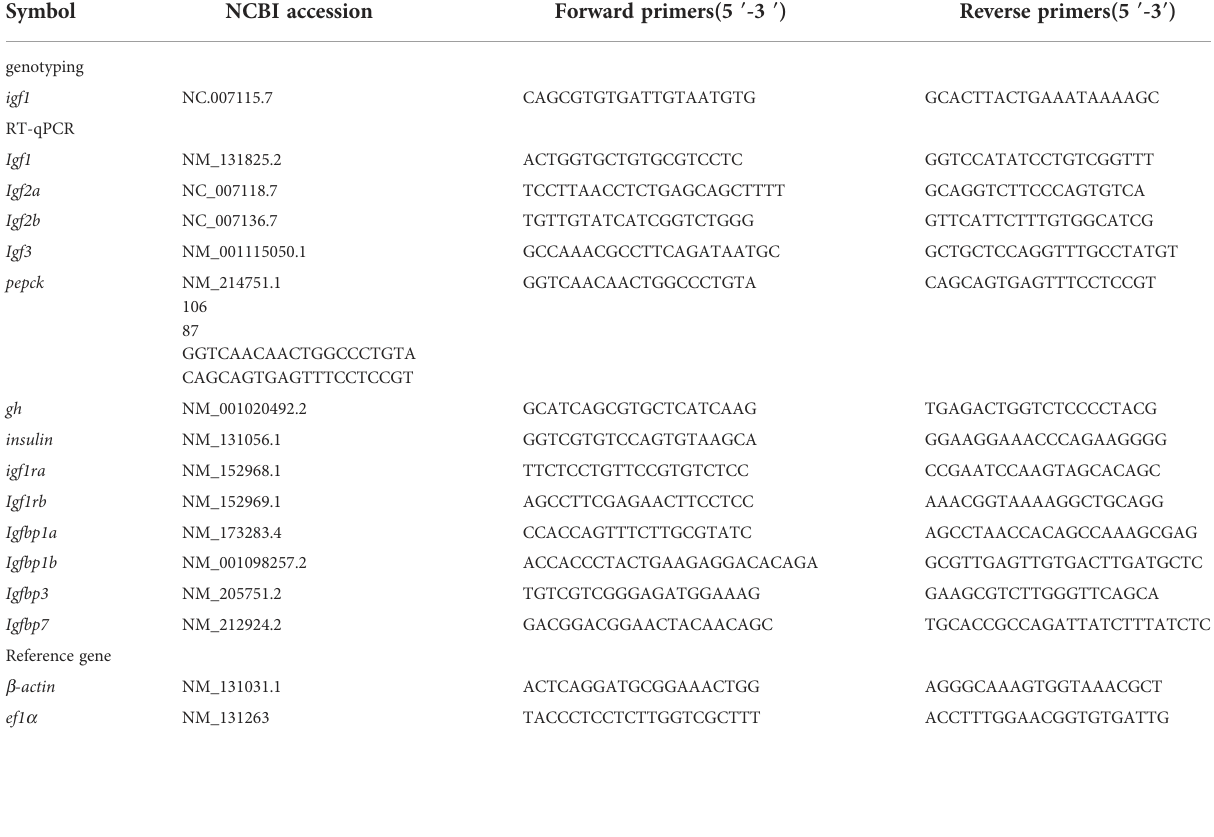
TABLE 1 The primers used in the